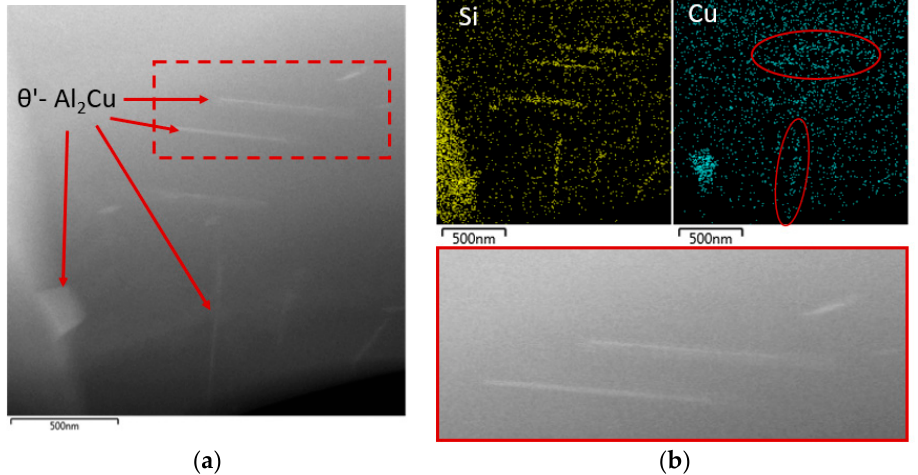
Figure 9. Substructure of 20–80 alloy after natural aging focus on θ ’-Al 2 Cu phases, TEM, STEM/HAADF; ( a ) 20–80 alloy, ( b ) Morphology of the θ ’-Al 2 Cu phase and distribution of Si and Cu elements and detail of needle morphology of θ ’-Al 2 Cu phase. Materials 2020 , 13 , x FOR PEER REVIEW